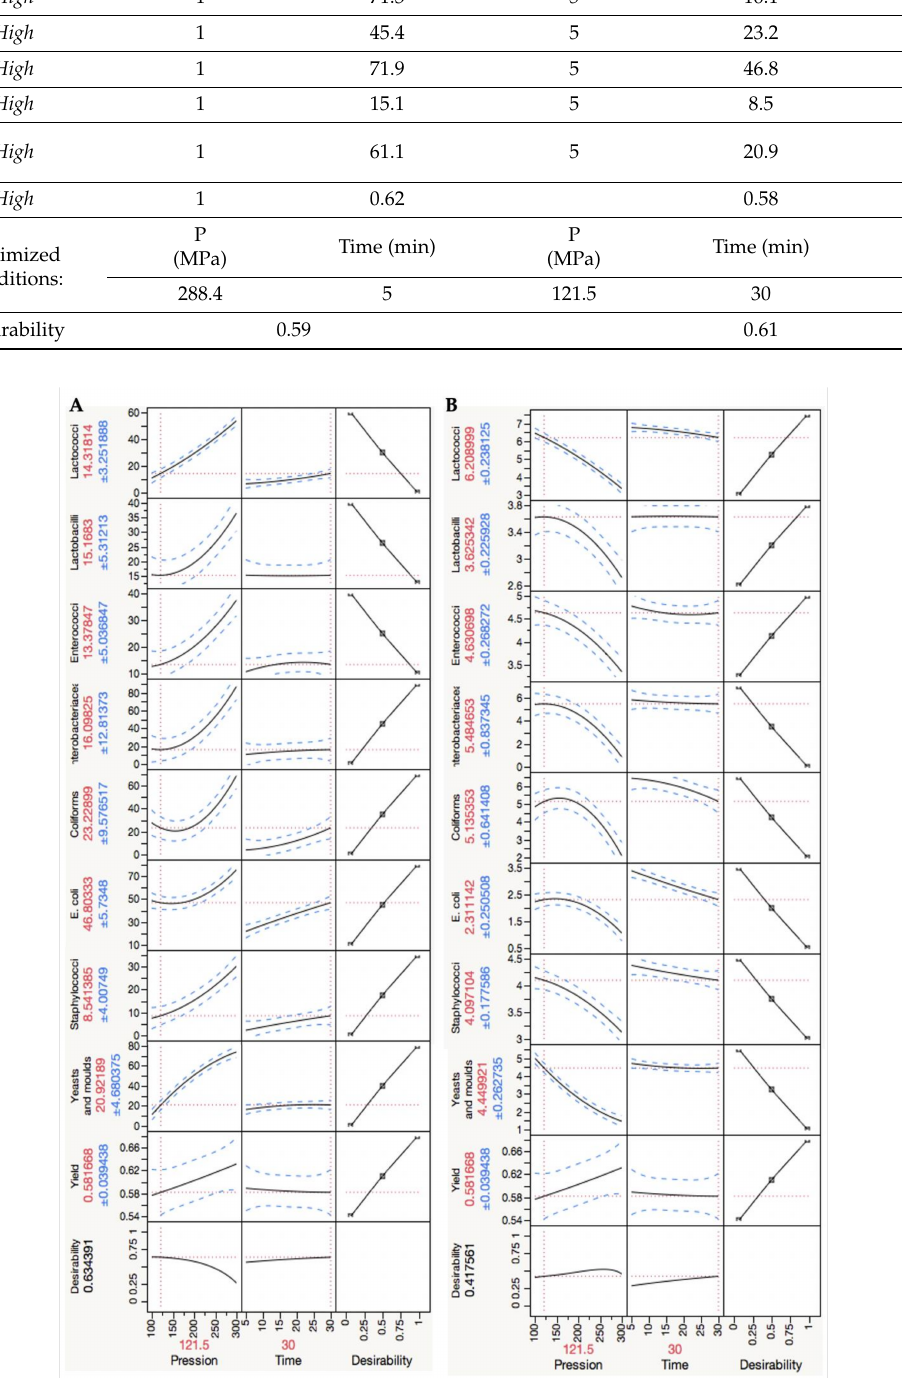
Figure 8. Design of experiment results: prediction profile of results optimization (by JMP9 software) of the surface model, assuming greater importance for lactobacilli and lactococci (quintuple of importance) and to enterococci (triple of importance). Equal importance was attributed to the remaining microbial groups/species. ( A ) Standard results are expressed in decimal reductions relative to the control load; ( B ) microbial viable cells